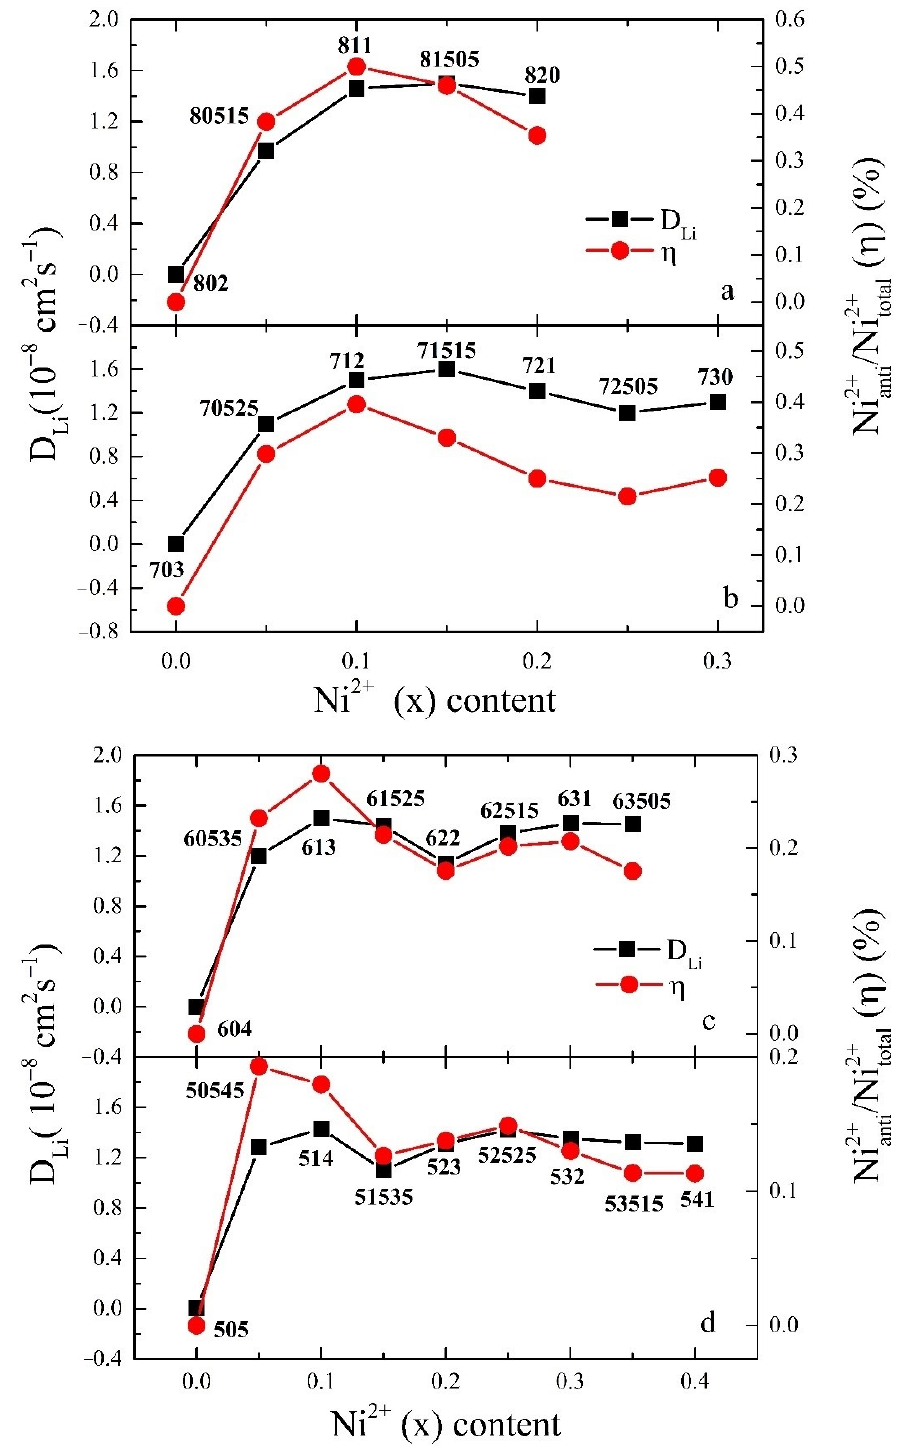
Figure 4. The ratio of anti-site Ni 2 + to total Ni 2 + and D Li in four series of NMC materials. Figure 4. The ratio of anti-site Ni (cid:2870)(cid:2878) to total Ni (cid:2870)(cid:2878) and D (cid:2896)(cid:2919) in four series of NMC materials. Black represents D (cid:2896)(cid:2919) and red represents η. ( a ) LiNi (cid:2868).(cid:2876) Mn (cid:2934) Co (cid:2868).(cid:2870)(cid:2879)(cid:2934) O (cid:2870) (x = 0, 0.05, 0.1 0.15, 0.2), ( b ) Black represents D Li and red represents η . ( a ) LiNi 0.8 Mn x Co 0.2 − x O 2 (x = 0, 0.05, 0.1 0.15, 0.2), LiNi (cid:2868).(cid:2875) Mn (cid:2934) Co (cid:2868).(cid:2871)(cid:2879)(cid:2934) O (cid:2870) (x = 0, 0.05, 0.1, 0.15, 0.2, 0.25, 0.3), ( c ) LiNi (cid:2868).(cid:2874) Mn (cid:2934) Co (cid:2868).(cid:2872)(cid:2879)(cid:2934) O (cid:2870) (x = 0, 0.05, 0.1, ( b ) LiNi 0.7 Mn x Co 0.3 − x O 2 (x = 0, 0.05, 0.1, 0.15, 0.2, 0.25, 0.3), ( c ) LiNi 0.6 Mn x Co 0.4 − x O 2 (x = 0, 0.05, 0.15, 0.2, 0.25, 0.3, 0.35), ( d ) LiNi (cid:2868).(cid:2873) Mn (cid:2934) Co (cid:2868).(cid:2873)(cid:2879)(cid:2934) O (cid:2870) (x = 0, 0.05, 0.1, 0.15, 0.2, 0.25, 0.3, 0.35, 0.4). 0.1, 0.15, 0.2, 0.25, 0.3, 0.35), ( d ) LiNi 0.5 Mn x Co 0.5 − x O 2 (x = 0, 0.05, 0.1, 0.15, 0.2, 0.25, 0.3, 0.35, The ratio of anti-site Ni (cid:2870)(cid:2878) ( Ni (cid:2911)(cid:2924)(cid:2930)(cid:2919)(cid:2870)(cid:2878) ) to total Ni (cid:2870)(cid:2878) ( Ni (cid:2930)(cid:2925)(cid:2930)(cid:2911)(cid:2922)(cid:2870)(cid:2878) ) is calculated for further anal- ysis, and we named it η, which is illustrated in Figure 4. The corresponding curves exhibit the same tendency. The maximum values of the corresponding curves are not the same